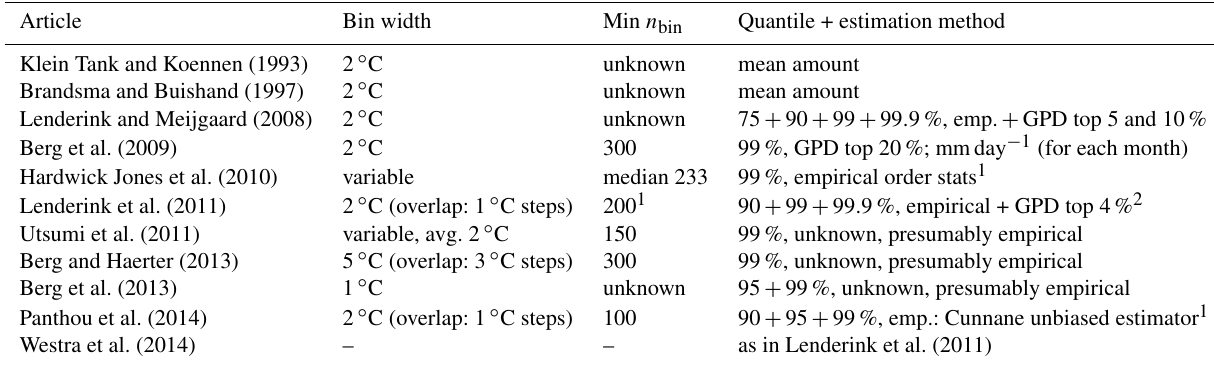
Figure 1. P – T relationships (99% quantile, hourly intensities) digitized from several figures in the literature on a logarithmic scale. Red dashed lines indicate CC scaling by the August–Roche–Magnus approximation (7% at 0 ◦ C, 6% at 20 ◦ C), see Panthou et al. (2014) and Hardwick Jones et al. (2010). Across regions and studies, P rises with T but then decreases. (a) Berg et al. (2013), Berg et al. (2009) (mmday − 1 ), and Berg and Haerter (2013). (b) Lenderink et al. (2011), Hardwick Jones et al. (2010), and Utsumi et al. (2011) (converted from mmday − 1 ). The last two articles use temperature bins of varying width with a semi-constant number of observations per bin. More details on study region and temperature variables can be found in Table 2. Table 1. P – T analysis methods used in the cited